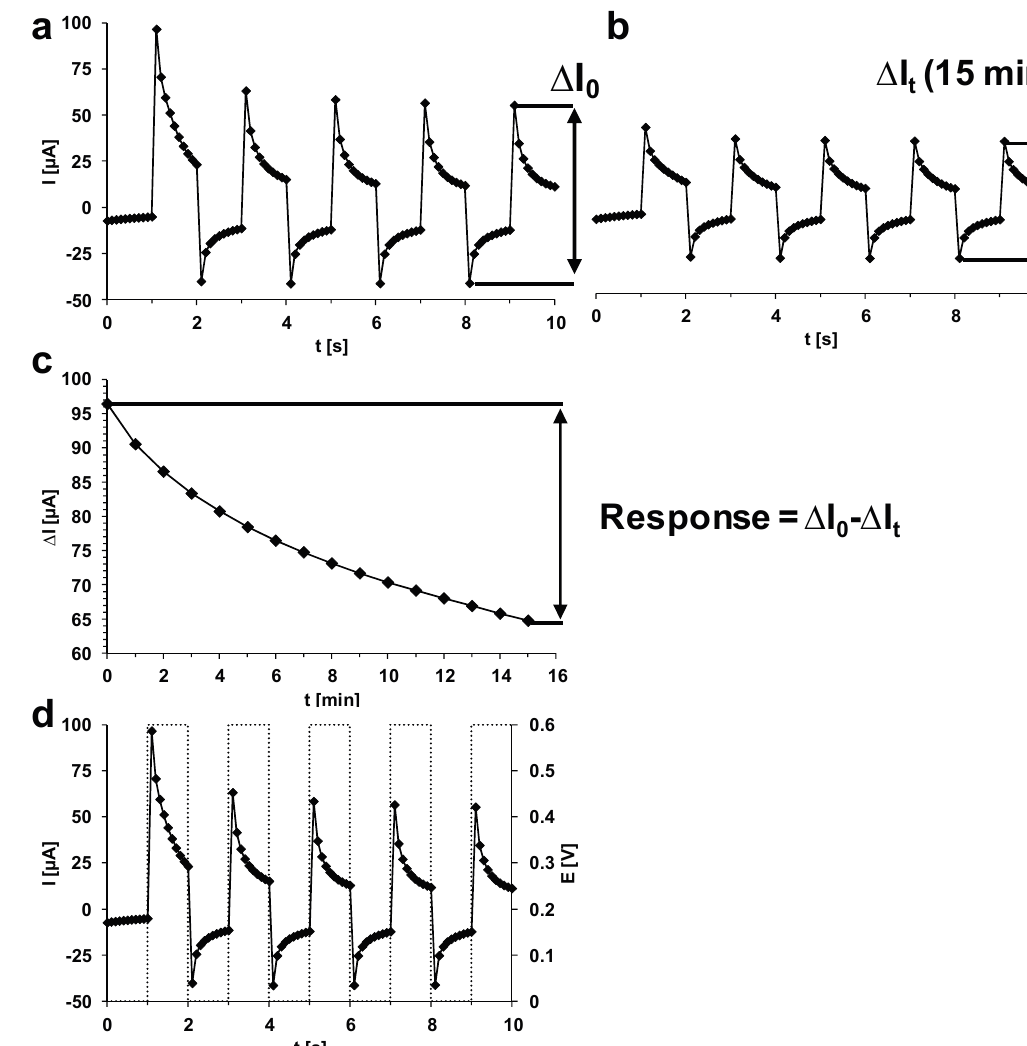
Figure A1. ( a ) PAD current response of polypyrrole during first application, last anodic and cathodic peak current gives ∆ I 0 ; ( b ) PAD current response during the 15th application, last anodic and cathodic peak current gives ∆ I 15 ; ( c ) Graph of ∆ I 1–15 against time, ∆ I 0 − ∆ I t gives sensor response. ( d ) Potential sequence and resulting